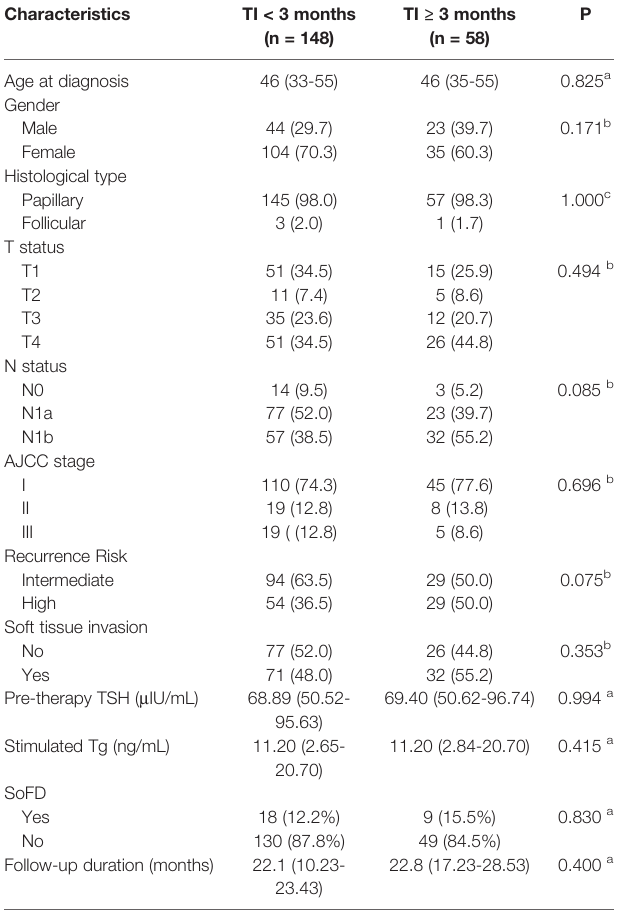
TABLE 1 | Clinical and pathologic characteristics. Characteristics